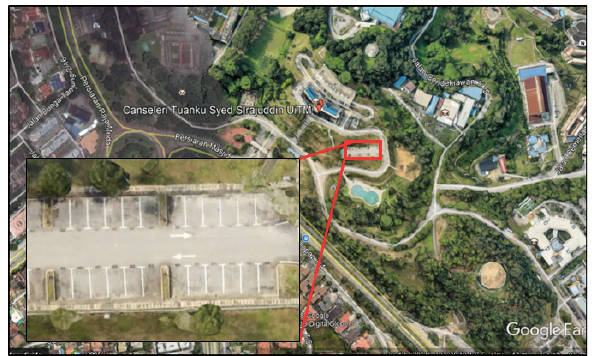
Figure 2. Car Park at Study